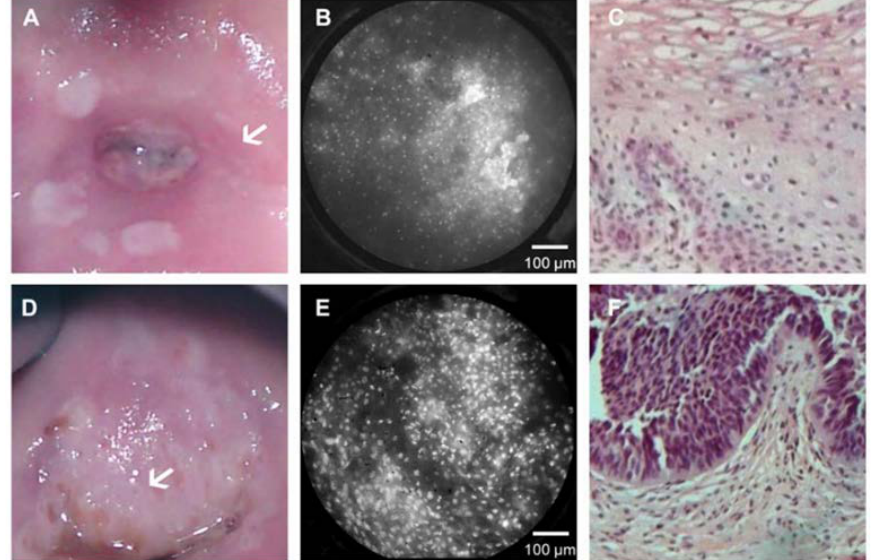
Figure 8. Representative cervix images of ( A , D ) the whole cervix, ( B , E ) the nuclei as seen by the HRME, and the ( C , F ) histopathology. The arrow points to the region of interest being imaged from A and D, shown in images B and E (Reprinted from Ref. [44]).